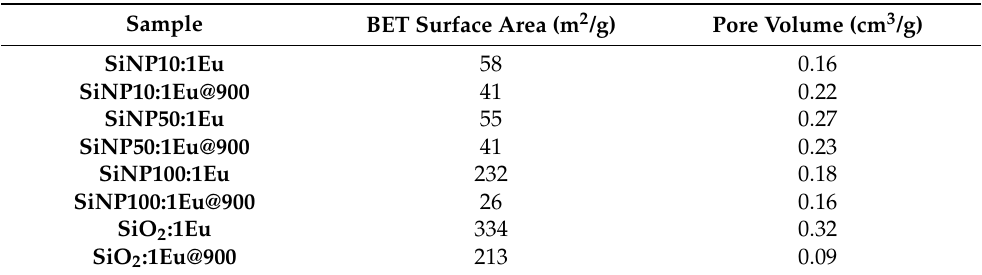
Table 2. Surface areas and pore volumes of SiNPX:1Eu and bulk SiO 2 :1Eu before and after thermal treatment at 900 ◦ C.